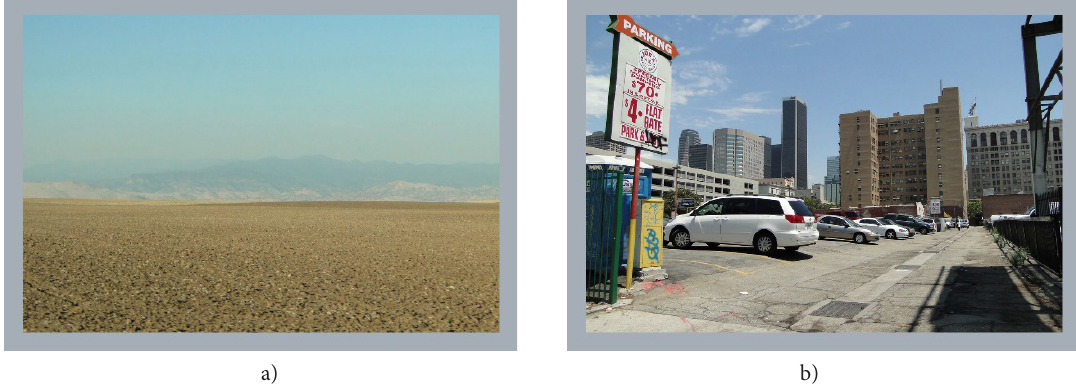
a) Figure 3. Examples of natural and urban views with pronounced negative characteristics: a) View 8 is a view of a ploughed field without vegetation and absence of picturesqueness. The absence of fascination as well as a low percentage of compatibility is evident; b) View 22 is a view of the parking lot without fascination , being away and extent . The absence of Lynch’s visual qualities singularity, dominance , continuity, and visual scope is evident